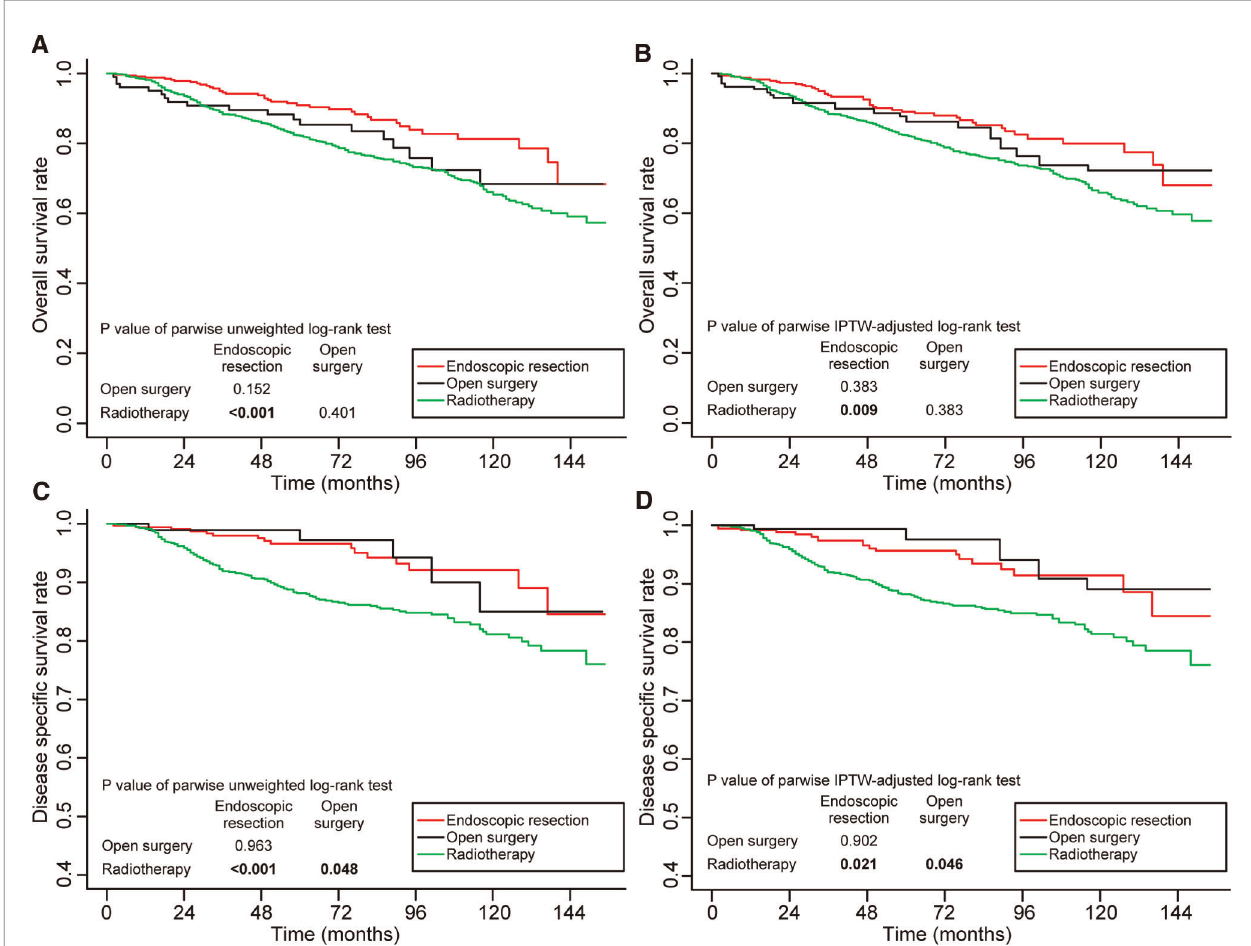
FIGURE 5 | Kaplan – Meier curves for overall survival ( A,B ) and disease-speci fi c survival ( C,D ) before and after weighting in the patients aged <65 years and in stage I. Signi fi cant p values are in bold font. IPTW, inverse probability of treatment